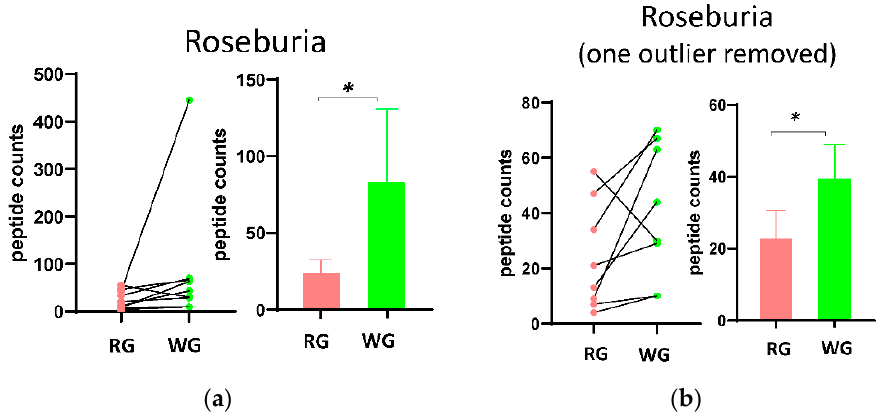
Figure 3. Changes in the composition and relative abundance of the stool microbiome. ( a , b ) Selected taxa differences between the two dietary treatments (RG and WG). paired t test: * p < 0.05.